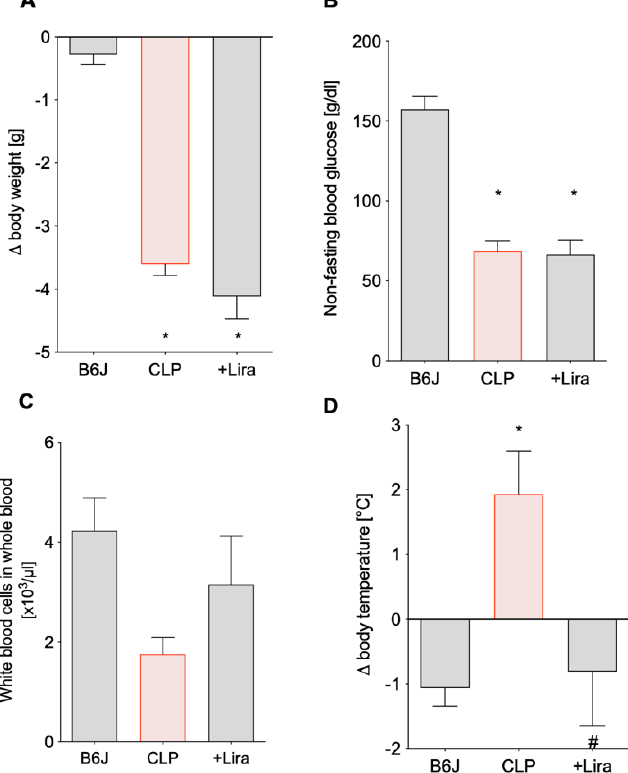
Figure 3. Treatment with the GLP-1 receptor agonist liraglutide protects against CLP-induced complications of leukopenia and hyperthermia without altering blood glucose levels in polymicrobial septic mice. ( A , D ) On day 0 and 3, animals were weighed and their temperature taken to determine Δ body weight and Δ body temperature, respectively. ( B , C ) Non-fasting blood glucose levels and white blood cell counts were evaluated in whole blood 2 days following sepsis induction. Data are the mean ± SEM of 22 – 26 ( A ), 19-22 ( B ) and 16-24 ( D ) measurements from individual animals or 6 individual blood samples (each pooled from 3 to 4 mice) ( C ). * p < 0.05 vs. B6J; # p < 0.05 vs. CLP.